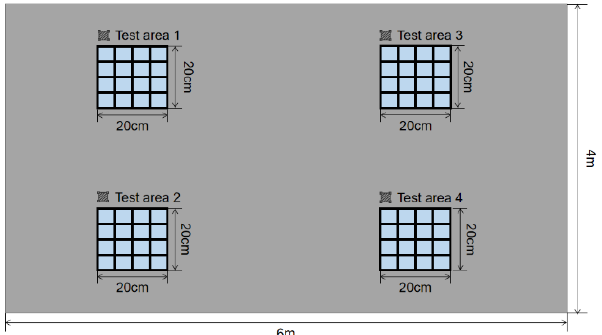
Figure 8. The schematic view of the measuring points for four test areas. Table 1. Test Results of Four Test Areas. Table 225.